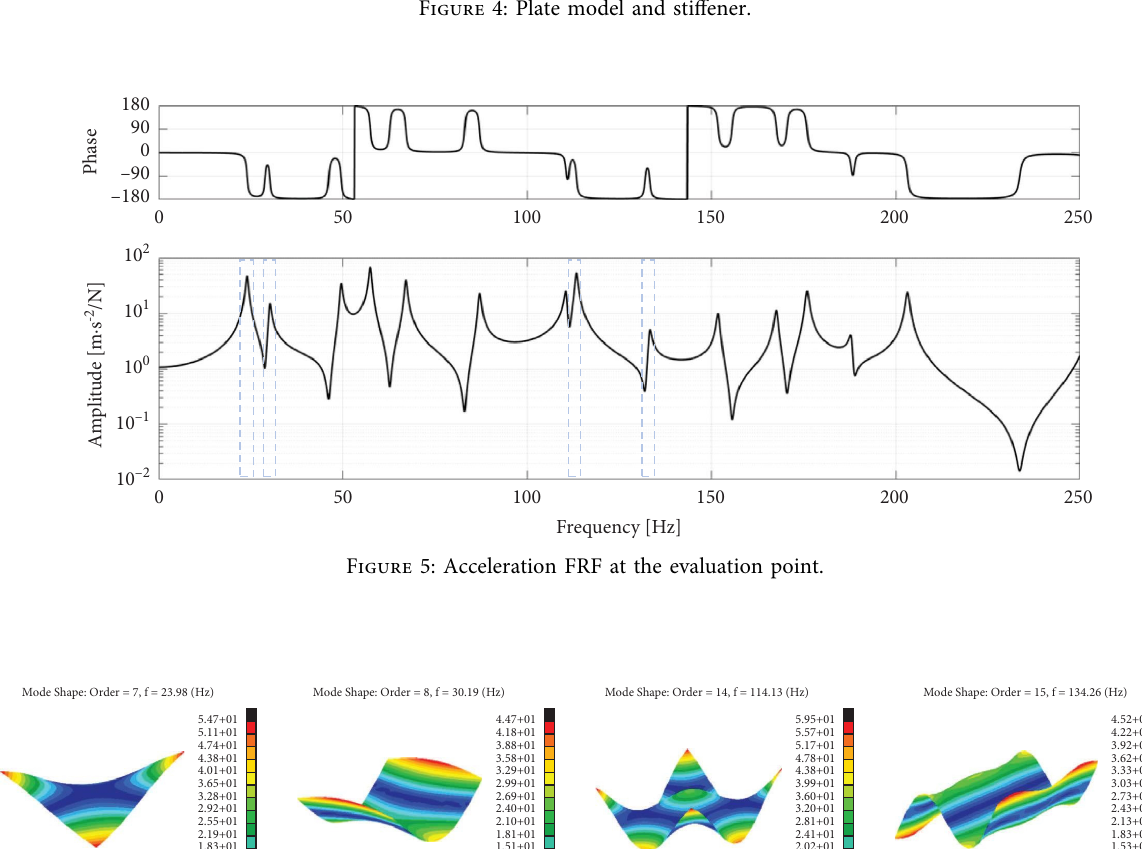
Figure 4: Plate model and stifener.